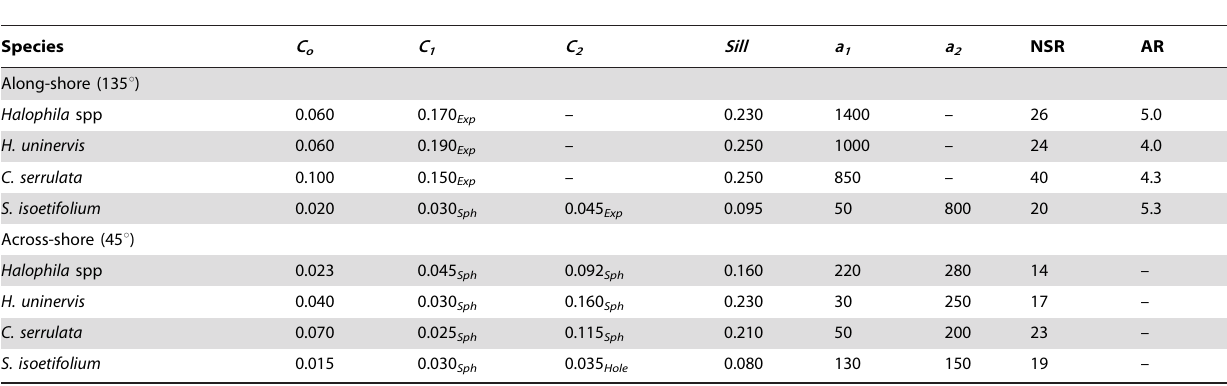
Table 2. Parameters of models fitted independently to variograms of the four seagrass species in Pulau Tinggi, Malaysia.